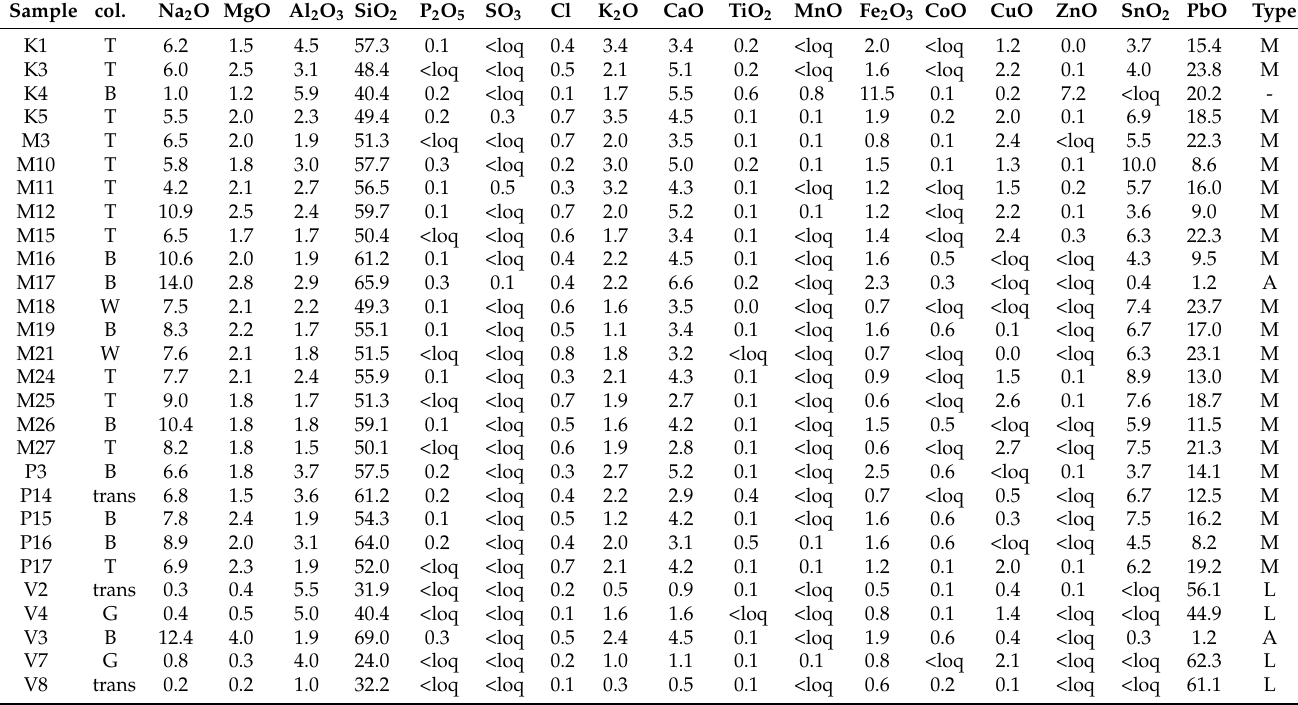
(Figure 5), while the SnO 2 content to opacify the glazes was <10 wt%. This is in contrast to the observation made by Kaczmarczyk on ceramics from Susa from the 12th to the 14th century, which are predominantly alkaline glazes and not opacified [17]. In general, the alkaline content is reduced as the lead content increases. An overview of the analytical data classified by colour and glaze type is given in Table S6. The lead content within glazes is known to be related to colour (e.g., the lead content in white glazes is on average higher than in blue glazes) [18]. Turquoise glazes showed the highest variation in lead content. The turquoise glazes dropped from the technical (K1, K3 and K5) were all in the range of a high lead content, between 15 wt% and 25 wt% PbO. Table 8. SEM/EDX results in wt% for the glazes, “<loq” indicates the compound was below the detection limit.